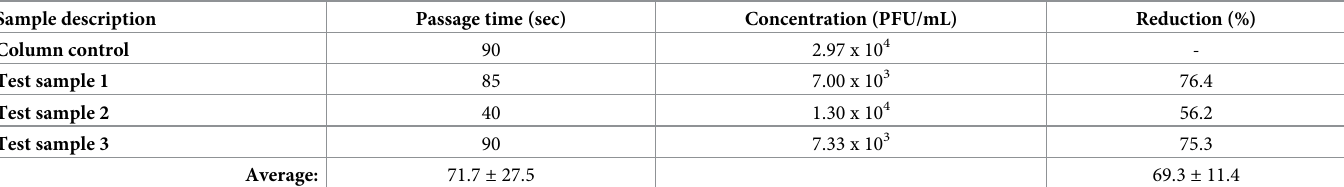
Table 3. NR-54009: Isolate hCoV-19/South Africa/KRISP-K005325/2020.